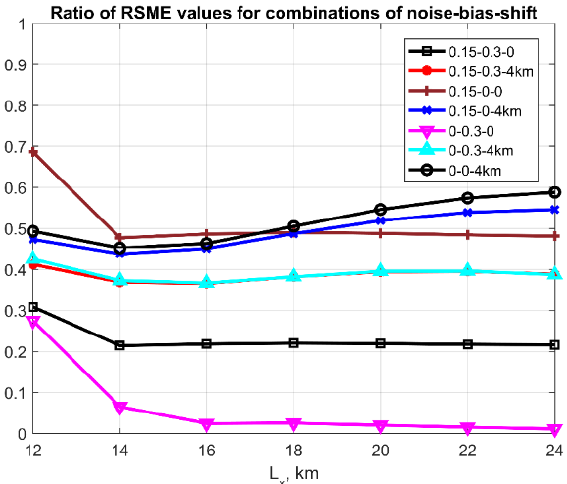
Figure 13. Ratio of RSME values of the child model relative to the true solution after and before NDA data assimilation as a function of eddy radius in the zonal direction x . Ratios are calculated for different combinations of errors generated by the child model: random noise (STD equal to either zero or 0.15), spatial shift (zero or 4 km), and bias (zero or 0.3). Percentages are shown with respect to the amplitude of the true signal. The first number in the legend shows the level of noise, the second shows the bias, and the third one shows the spatial shift.